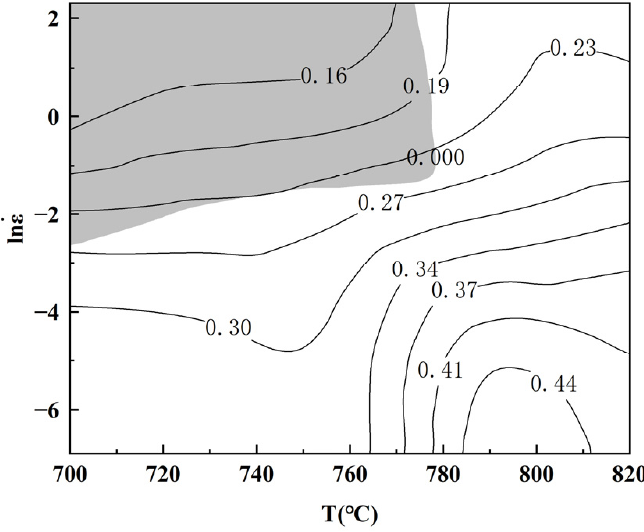
Figure 11. Processing map for 0.6 strain.